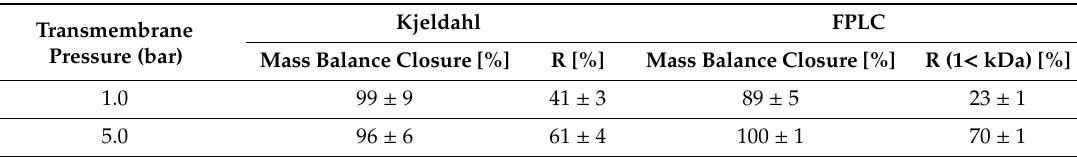
Table 9. Membrane processing of sardine cooking wastewaters: mass balance of total protein / peptides by Kjeldahl and FPLC methods, the observed rejection of total protein / peptides by the Kjeldahl method, and the observed rejection of peptides (with MW < 1 kDa) by FPLC